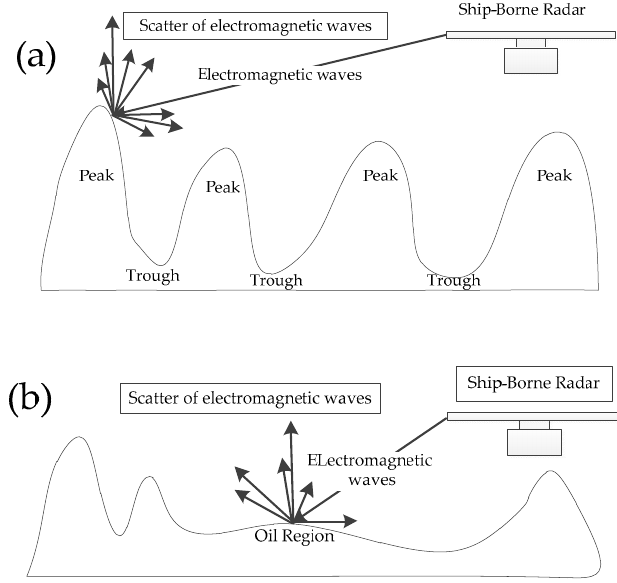
Figure 1. Ship-borne radar oil spill detection mechanism. Radar electromagnetic wave echo-creation principles are shown for ( a ) a normal sea surface and ( b ) an oil-film area.